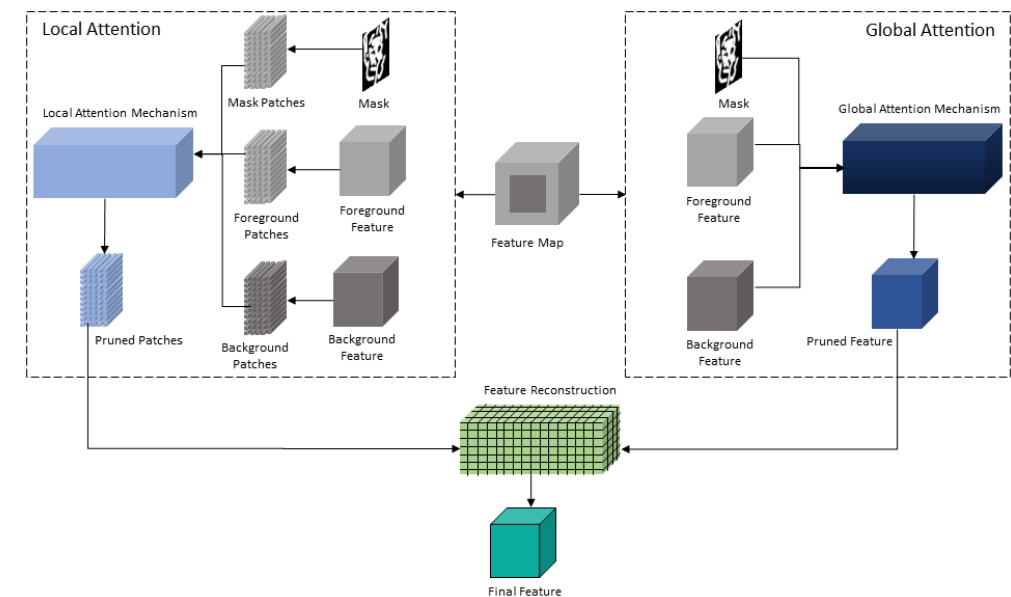
Figure 4. Overview of the proposed GLA module. Our proposed module takes the foreground and background feature maps and calculates both the global attention and local similarity for a refinement of the coarse output. It then calculates the pruned feature from the global attention mechanism and pruned patches from the local attention mechanisms for calculating the local similarity based on the inner product. It then uses the pruned patches to reconstruct the final feature